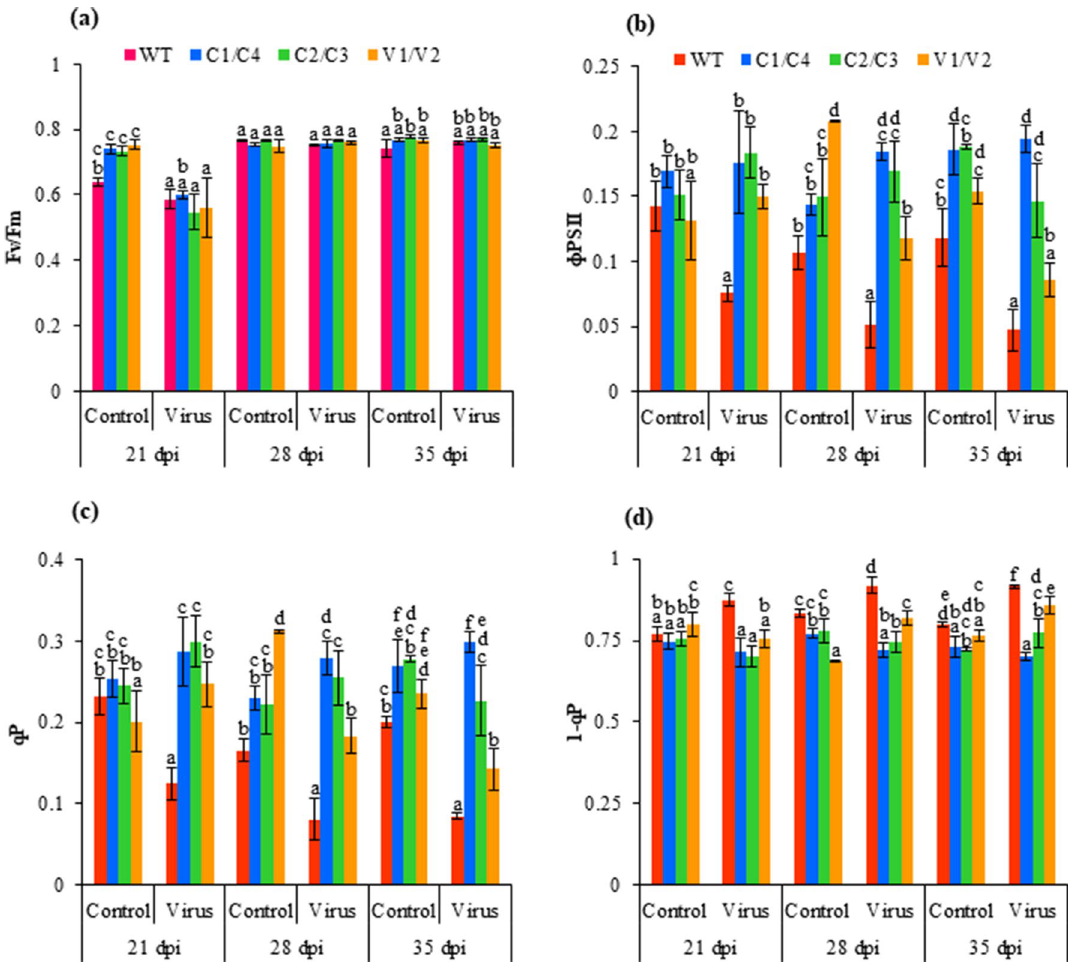
Figure 4. Analysis of chlorophyll fluorescence parameters of WT, C1/C4, C2/C3 and V1/V2 amiRNA plants with and without JLCuGV agroinfiltration. ( a ) ΦPSII, ( b ) Fv/Fm ratio ( c ) qP and ( d ) 1-qP. Values are represented as means ± SD (n = 3) and marked with different alphabets to indicate a significant difference as determined by Tukey test at P ≤ 0.05